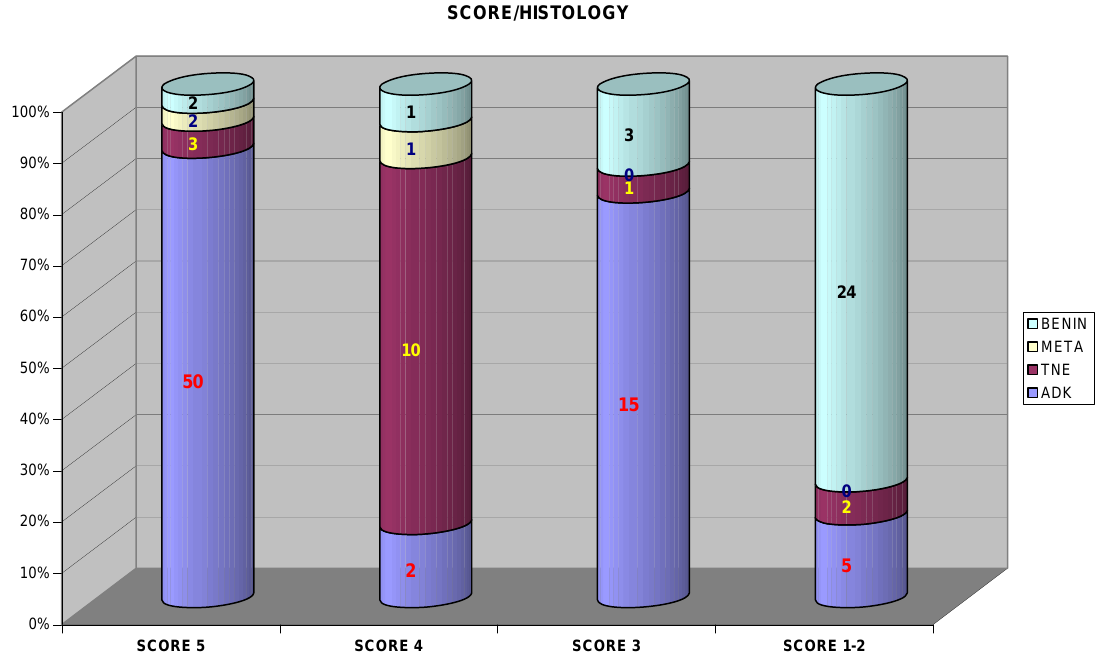
FIGURE 18 . Multicentric study: correlation between elastography score and histology for pancreatic